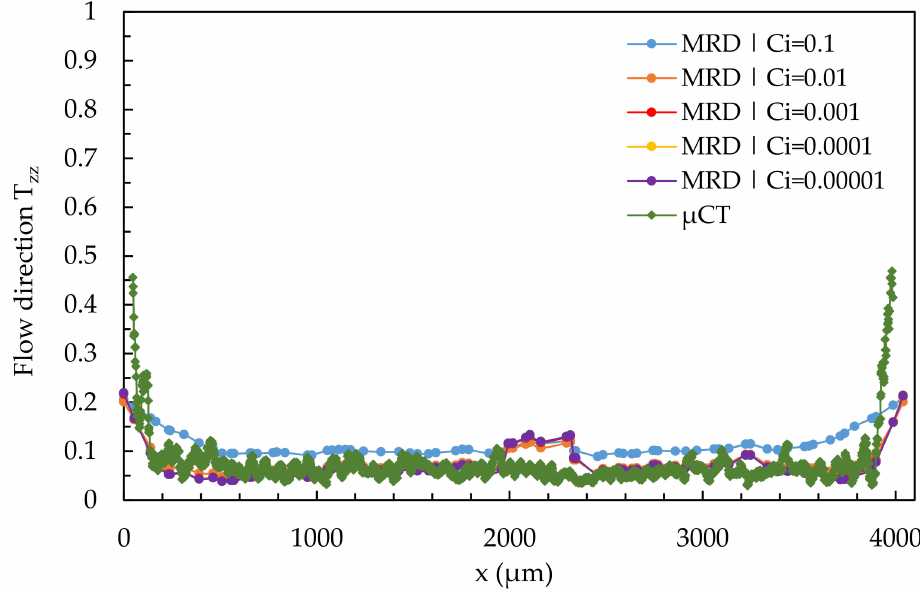
Figure 16. Quantitative results of fiber orientation in T zz -direction over the cross-section characterized by µ CT and predicted by the 3D mesh under variation of the fiber interaction coefficient C i at location